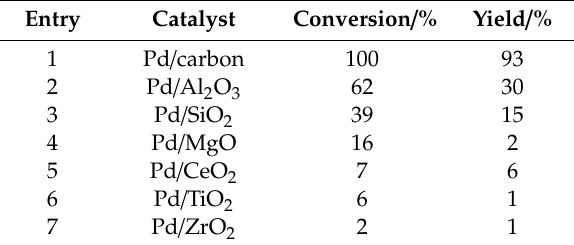
Reaction conditions: catalyst (50 mg), benzaldehyde (1 mmol), formic acid (1.5 mmol), THF (3 mL), 100 °C, 6 h, 500 rpm.